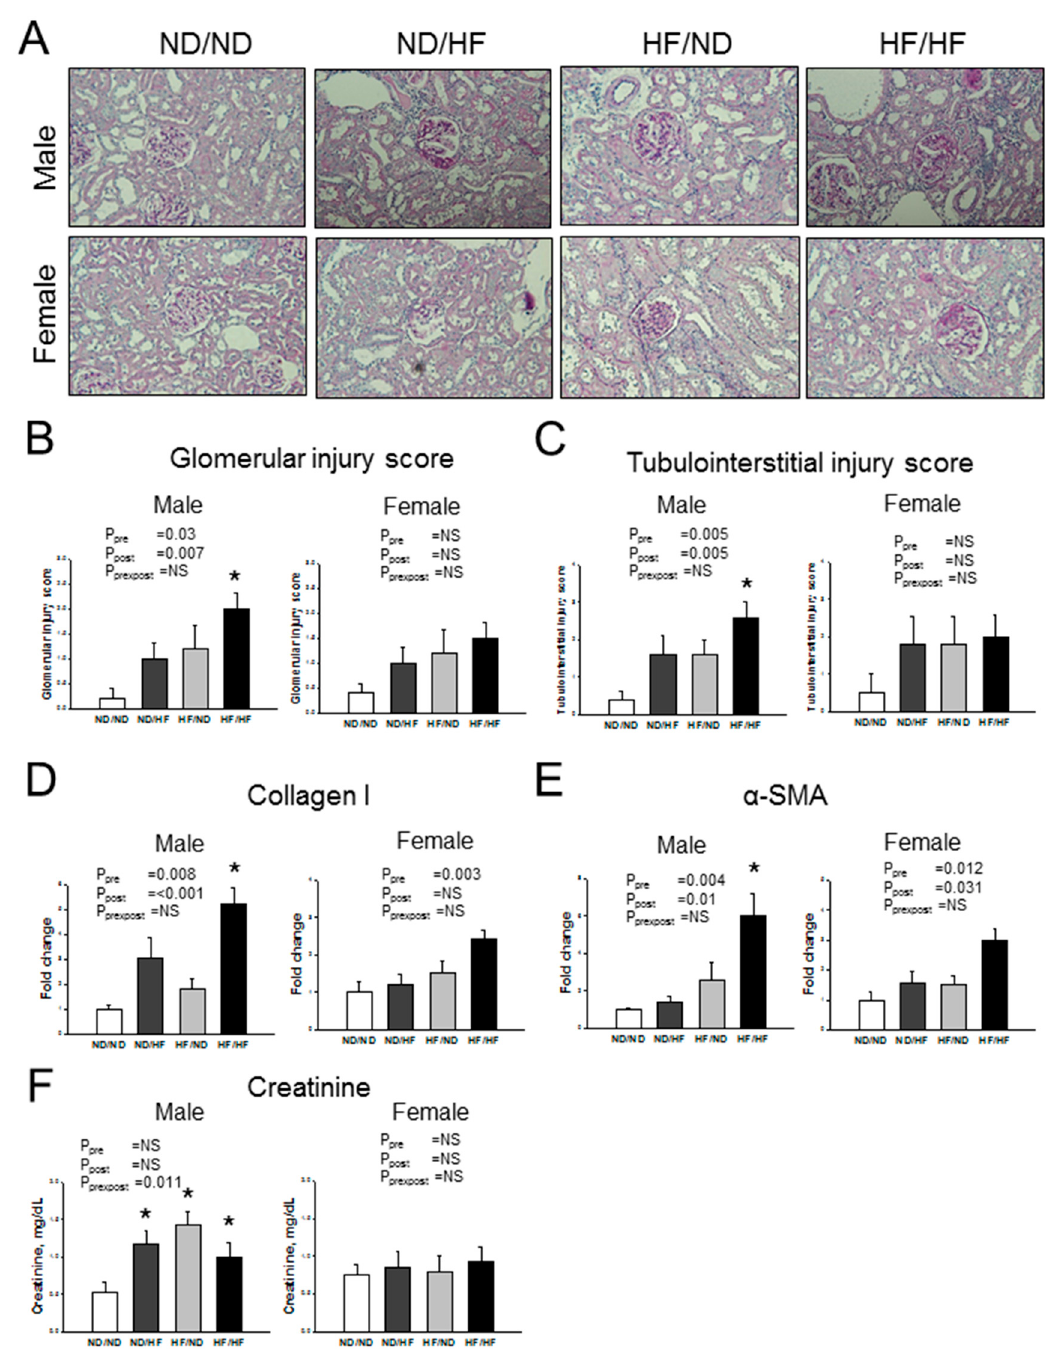
Figure 3. Maternal and post-weaning HF diet induced greater degrees of kidney injury in male than female offspring. Effects of maternal and post-weaning HF diet on: ( A ) morphological changes; ( B ) glomerular injury; ( C ) tubulointerstitial injury; ( D ) mRNA expression of collagen I; ( E ) α -smooth muscle actin ( α -SMA); and ( F ) creatinine level. Pre × Post, interaction of pre × post; NS, not significant; * p < 0.05 vs. ND/ND; N (pups/L) = 5-7/3 per group.